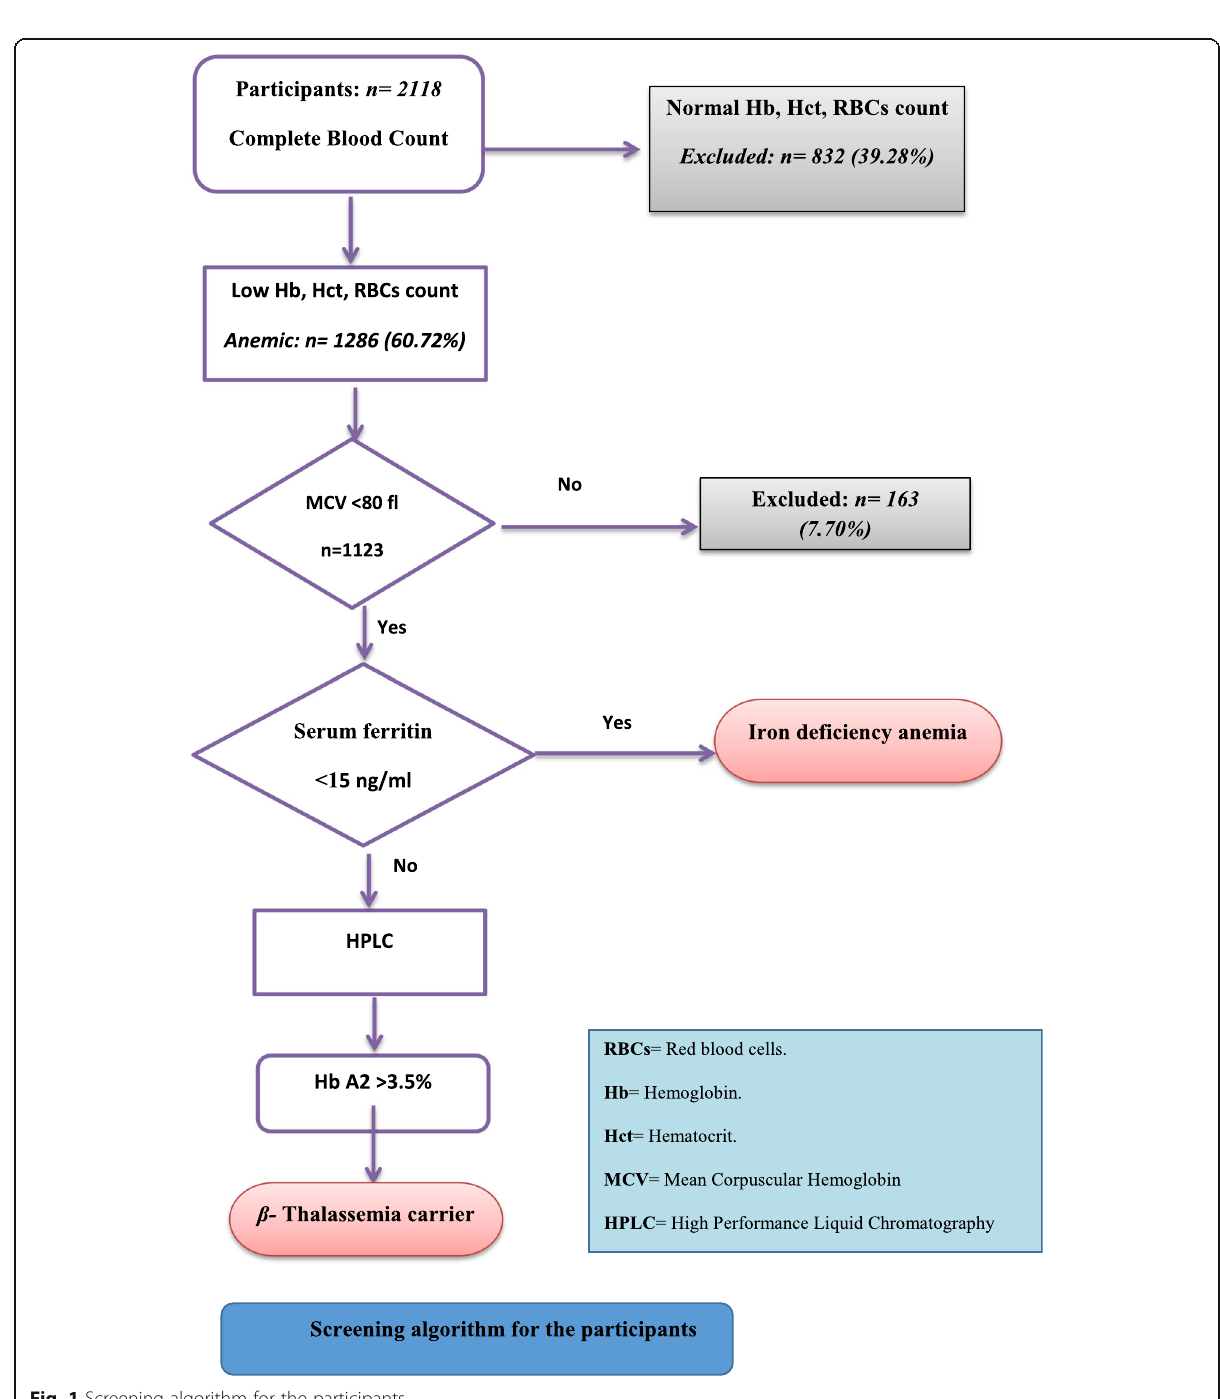
Fig. 1 Screening algorithm for the